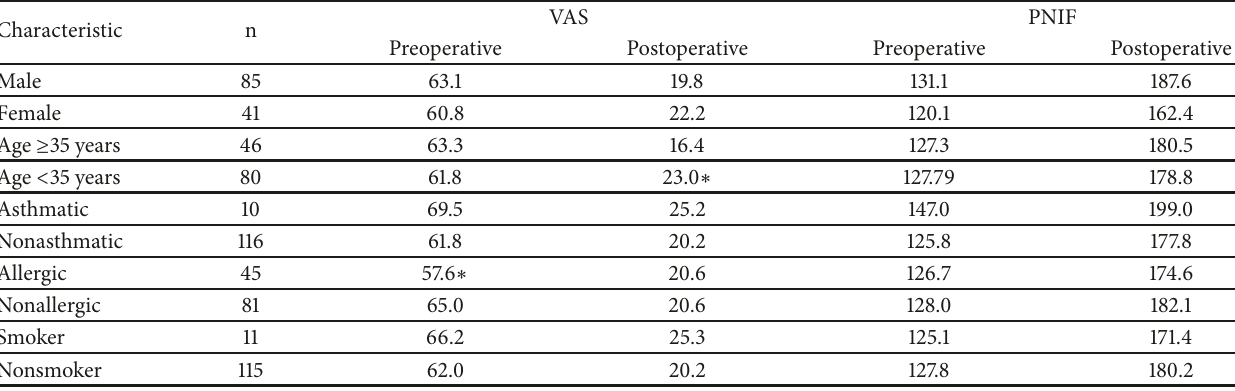
Table 2: Preoperative and postoperative VAS and PNIF scores by patient characteristics.